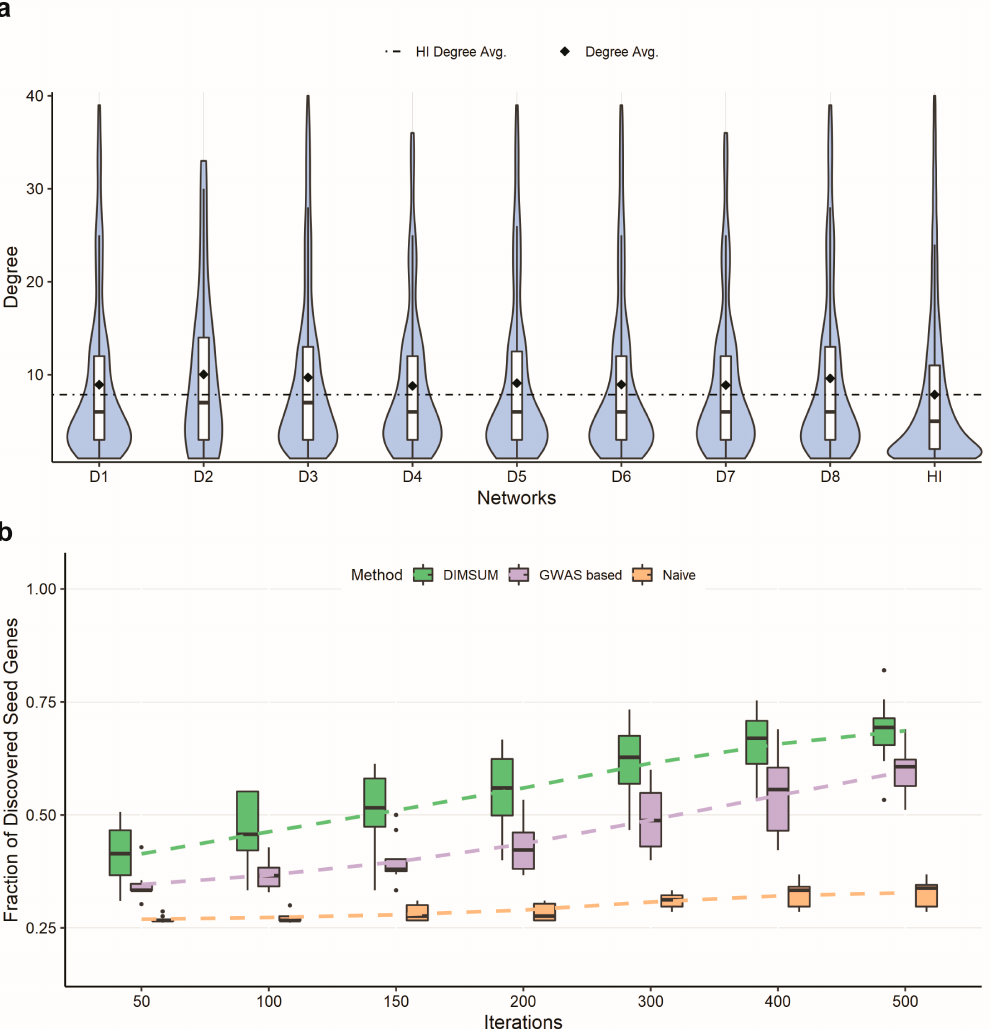
Figure 2. Annotated networks and comparison of DIMSUM against a naïve and a GWAS based network propagation procedures. ( a ) The first eight violin plots represent the node degree distributions of disruptively mutated genes for eight complex diseases; the last violin plot is the node degree distribution of all genes in the human interactome (HI); the avg. degree of the disrupted genes is much greater than the avg. degree of HI, showing that highly connected genes are disrupted. ( b ) Comparison of the seed genes discovered when randomly selecting 25% of the seed gene pool as seeds. Each box plot represents the fraction of discovered seed genes across all eight diseases from DIMSUM, a GWAS based and a naïve network propagation at di ff erent iterations. DIMSUM performs significantly better than the other two approaches at the initial 50 iterations and improves drastically with increasing